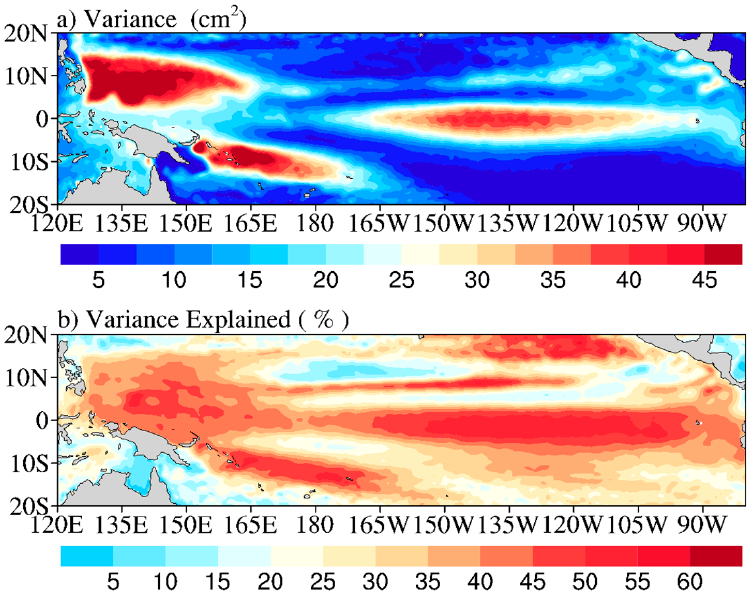
Figure 5. ( a ) The interannual sea level variances and ( b ) explained variances in the TPO. From the perspective of atmospheric forcing, variations in the wind field and heat flux caused variations in ocean density field and circulation. These can induce variations in heat content and other factors, in turn causing sea level variations. Therefore, the root causes of the interannual variations are the variations of the wind field and heat flux [12,29]. The contribution of the steric effect to the interannual sea level variations in the TPO is generally significant (Figure 6), as high as 95% in the central TPO. However, there is a small area of less than 15% and even a negative contribution in the northernmost and southeastern regions. The dynamic process contributes significantly (55–80%) to the interannual sea level variations in the TPO, mainly influencing the northwest, northeast, and southern regions, and contributed less (<45%) in other regions. This is consistent with the results of previous studies [12,20,41]. The contributions of the steric effect and the dynamic process to the interannual sea level variations vary. For instance, while the contribution of the dynamic process is unevenly distributed spatially, its effect in most regions exceeds 85%. Therefore, in most regions of TPO, the steric effect and the dynamic process explains the interannual sea level variations. Similar conclusions have been reflected in previous studies